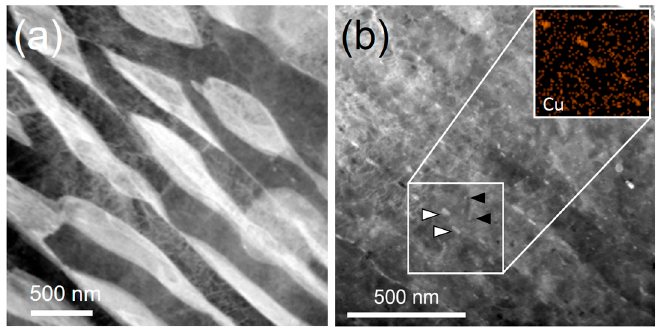
Figure 11. High-angle annular dark-field (HAADF) image showing microstructure in ( a ) S690Q steel and ( b ) NiCu steel after a 720 °C tempering for 1 h.